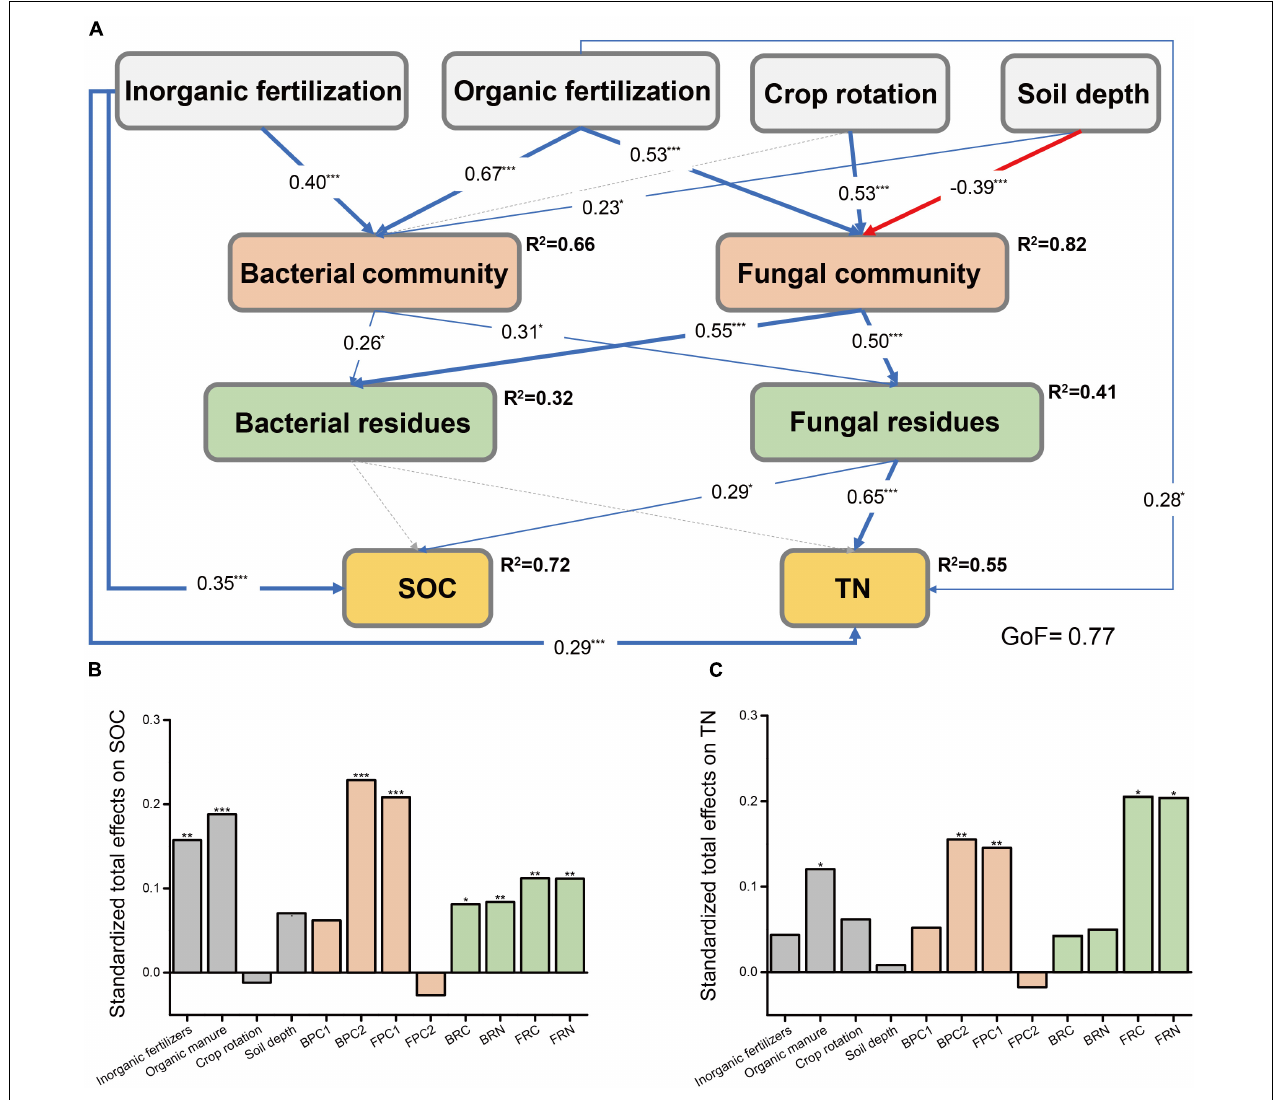
FIGURE 2 | The partial least squares path models illustrating the effects of fertilization regimes, crop rotation, and soil depth on soil C and N by influencing the distribution of living and dead microorganism. (A) Bacterial and fungal communities were represented by the PC1 and PC2 of bacterial and fungal PCoA, respectively. Bacterial residues contained bacterial residues C and N. The blue and red lines indicated significant positive and negative correlations, respectively, while gray dash lines indicated insignificant correlation. The data on lines indicated the coefficient, and R 2 indicated the coefficients of determination of the variables. GoF, goodness of fit. The cumulative bar plot displayed the standardized total effects of variables on SOC (B) and TN (C) . The asterisk indicated significant differences, * p < 0.05, ** p < 0.01, *** p < 0.001. BPC1, sample values in PC1 axis of bacterial PCoA; BPC2, sample values in PC2 of bacterial PCoA; FPC1, values in PC1 of fungal PCoA; FPC2, values in PC2 of fungal PCoA; BRC, bacterial residues C; BRN, bacterial residues N; FRC, fungal residues C; FRN, fungal residues